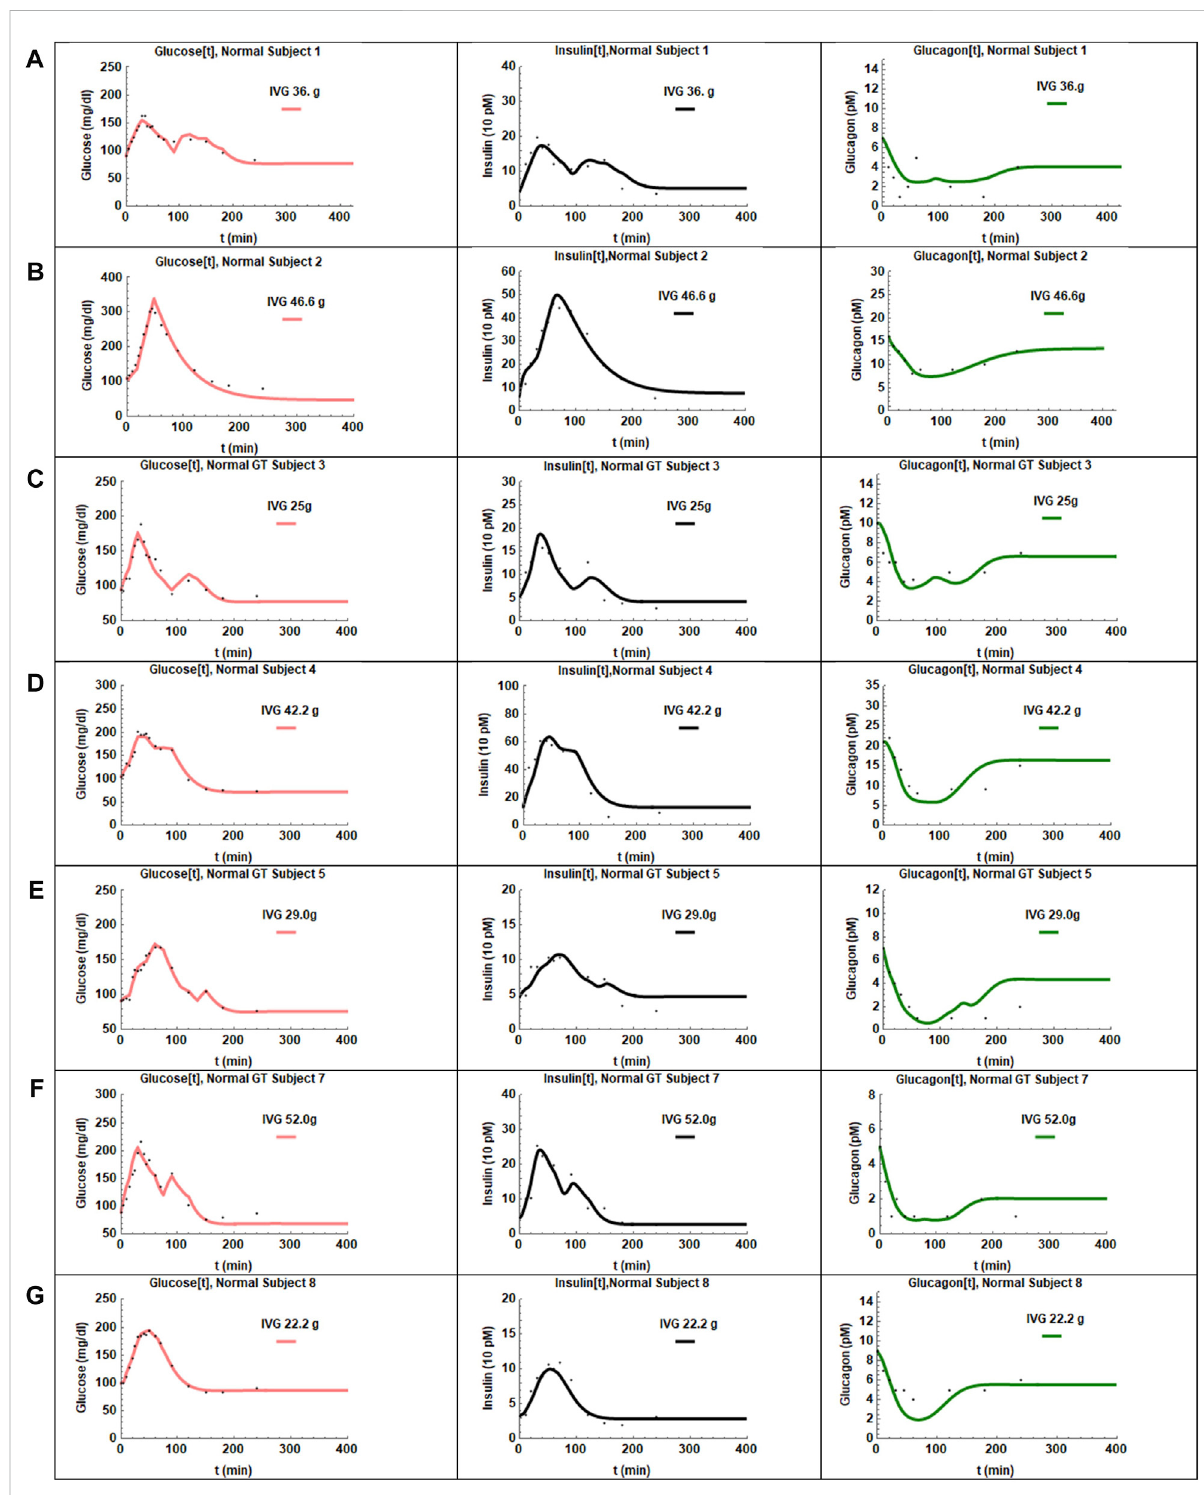
FIGURE 3 The fi tsobtained for the seven CSsubjects are presented inpanels (A – G) . The adjusted R 2 valueswere > 0.97 for all the fi ts. The glucose pro fi les were fi t the best by the model. In some cases, the insulin recovery was not captured perfectly (D,E) . Glucagon shows very slow recovery and is captured reasonably well by the hysteresis model except for one subject (E)